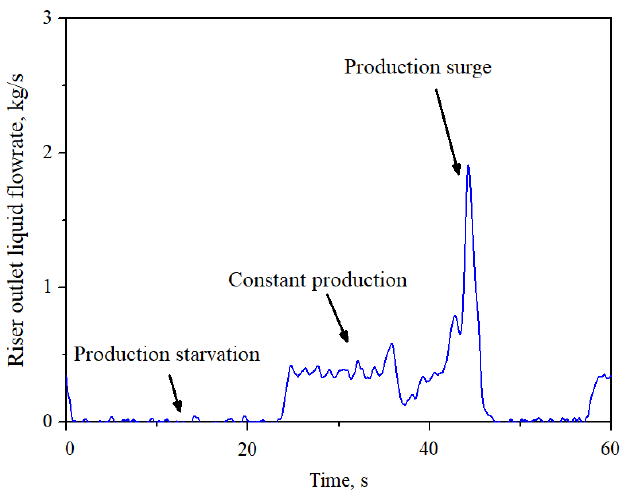
Figure 8. Experimental profile of slug production for severe slugging ( U GS = 0.08 m/s and U LS = 0.09 m/s).